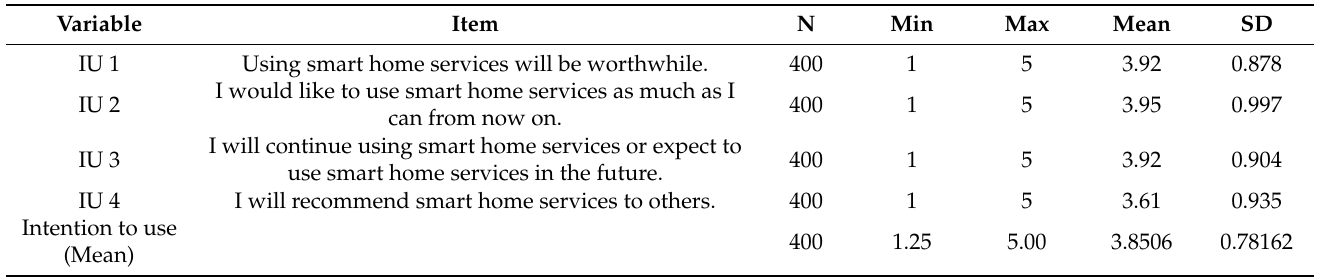
Table 4. Mean of Intention to